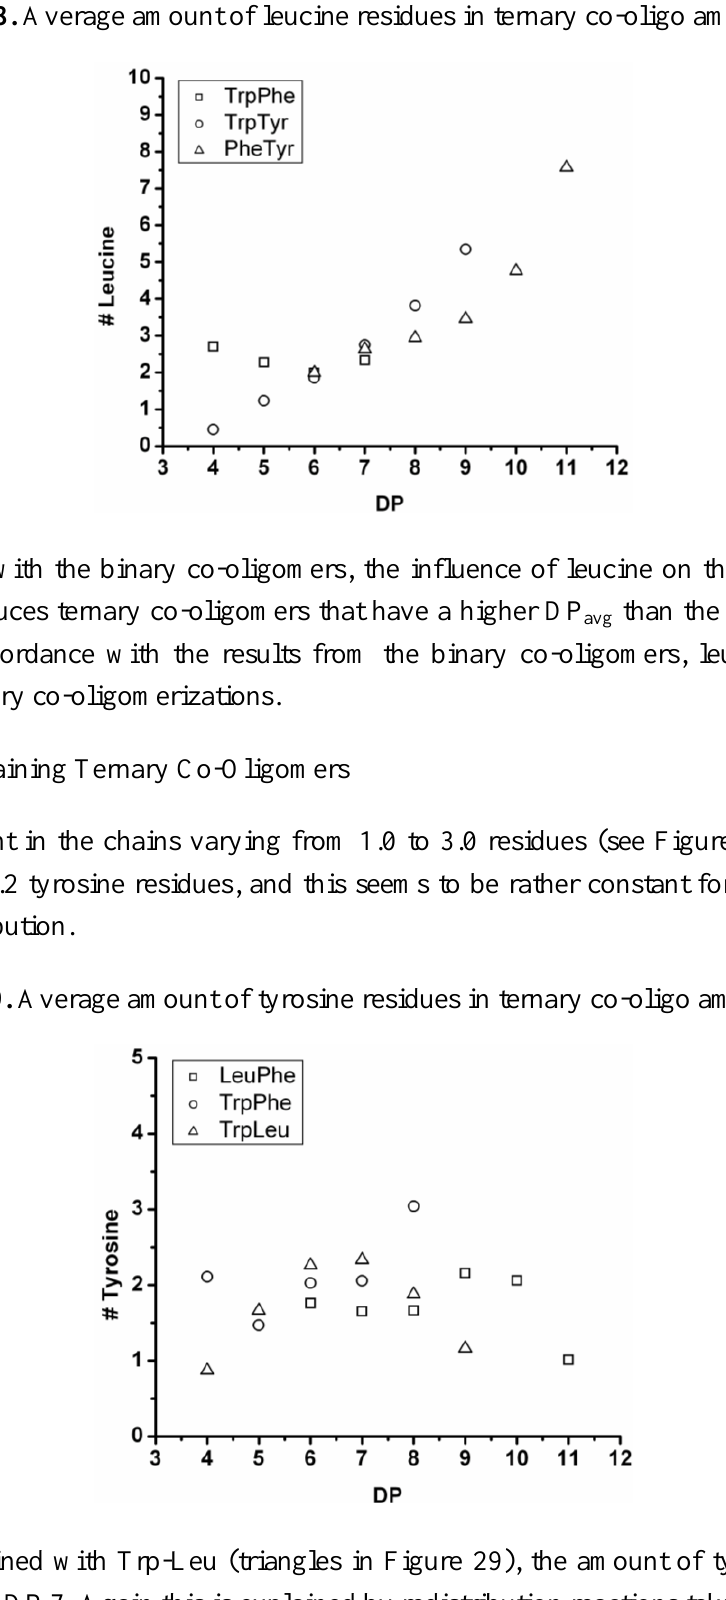
Figure 28. Average amount of leucine residues in ternary co-oligo amino acids.